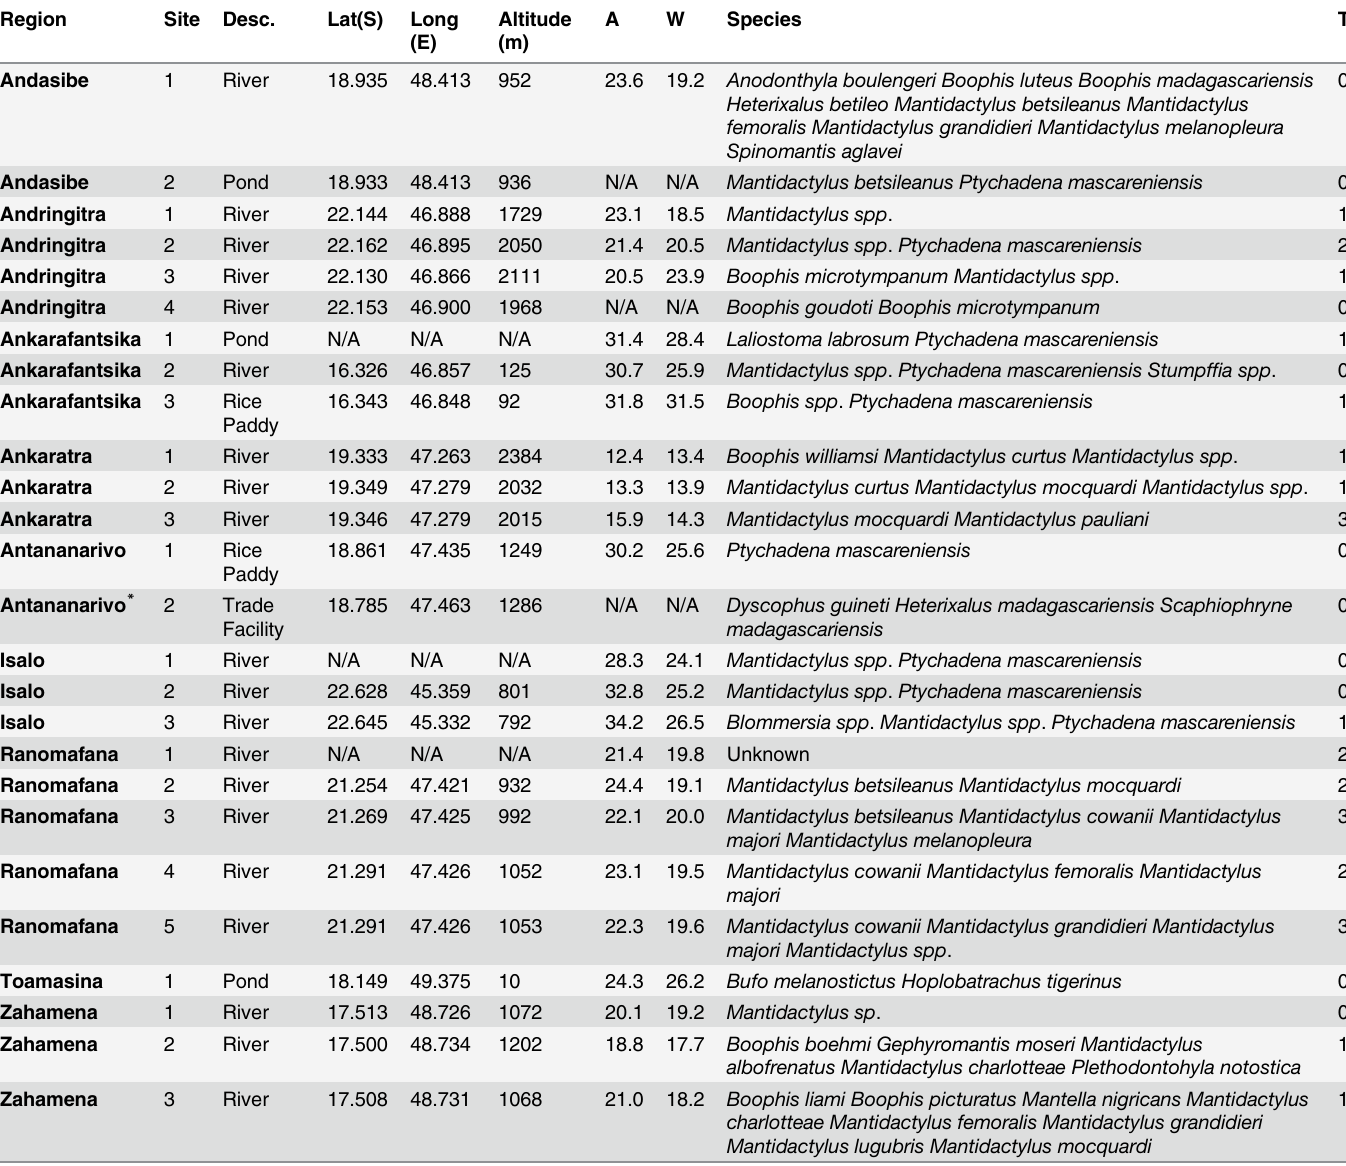
Table 1. Site summary and diversity of amphibians sampled for the presence of Batrachochytrium dendrobatidis ( Bd ) and ranavirus in Madagascar. Region Site